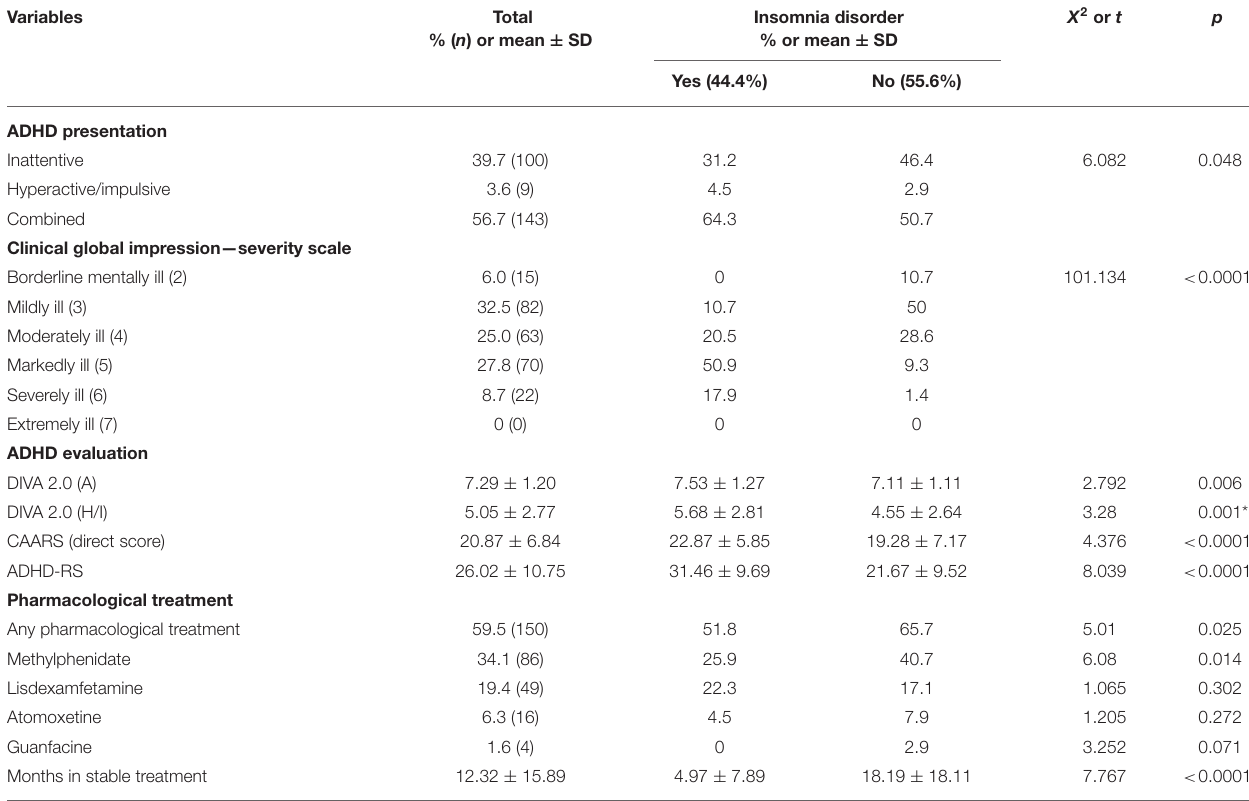
TABLE 2 | ADHD variables related to insomnia disorder.